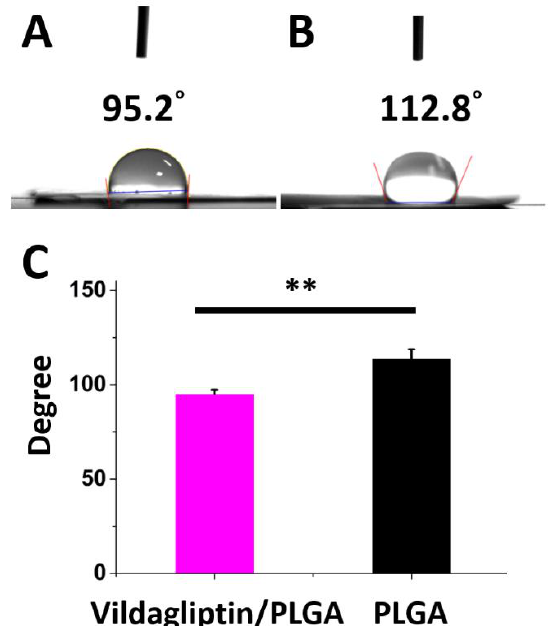
Figure 3. The photos ( A ) and measured water contact angles ( B ) of biodegradable nanofibrous membranes both with and without vildagliptin ( C ) (** p <